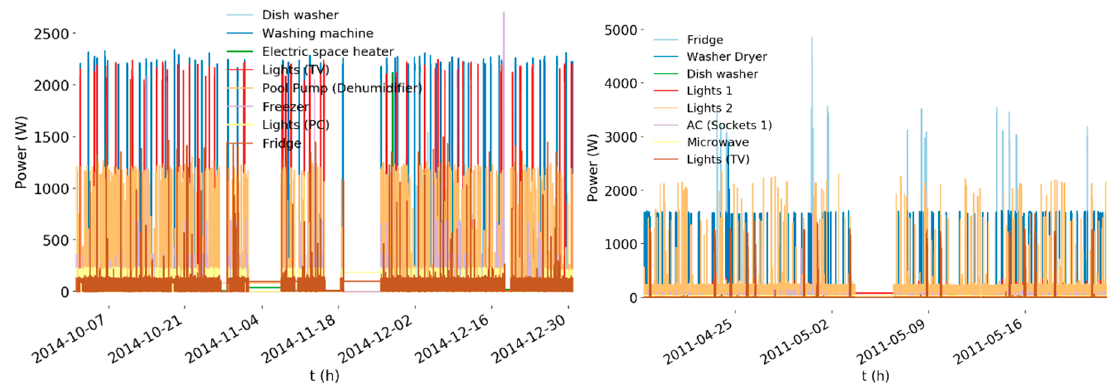
Figure 4. Disaggregated Training data for defined time windows: Refit dataset using combinatorial optimisation (CO) ( left) , and Residential Energy Disaggregation Dataset (REDD) dataset using Factorial Hidden Markov Model (FHMM) ( right ).